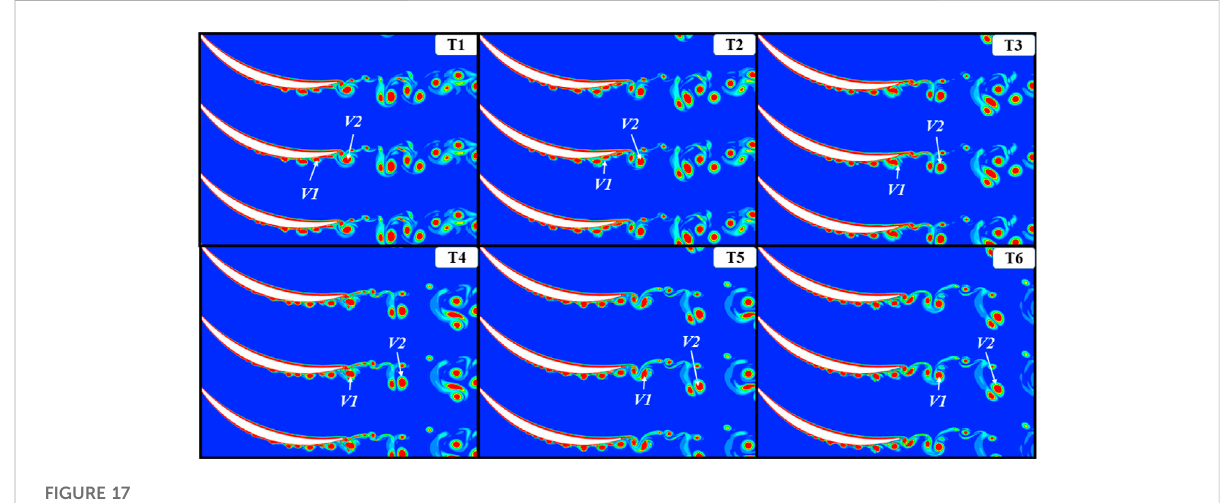
FIGURE 17 Rough cascade vorticity ( k + s =11.80)